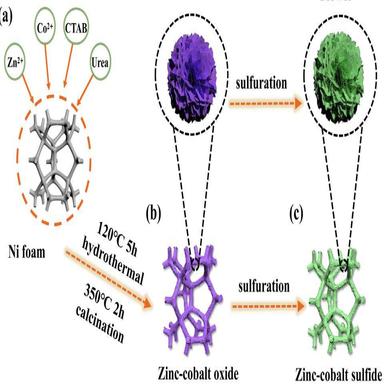
Schematic representation of the synthesis process of ZCSd.